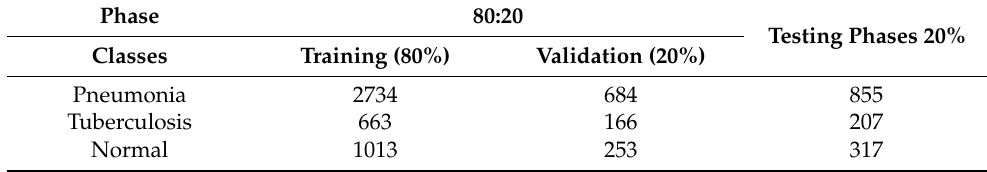
Table 1. Splitting of pneumonia and tuberculosis data set during implementation phases.